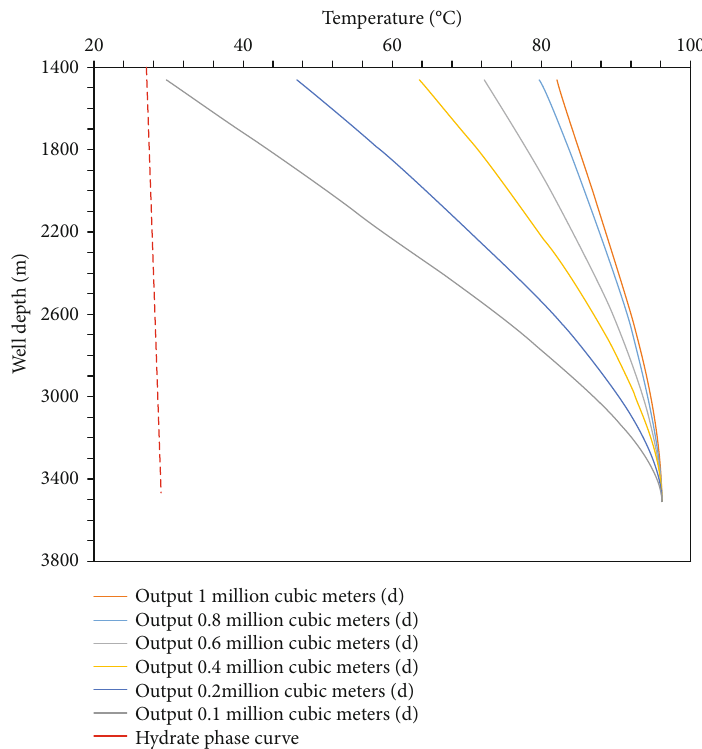
Figure 5: Hydrate formation region prediction at production period.